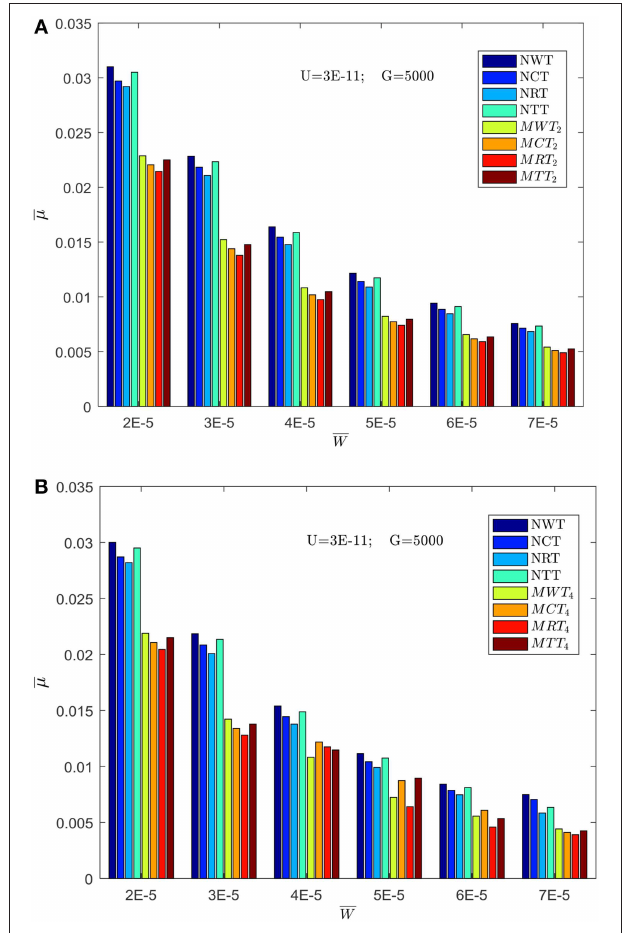
FIGURE 9 | Effect of MHD lubricant parameter [Hm (A) 2, (B) 4] and MTS on coefficient of friction in the inlet zone of EHL line contact at U = 3 × 10 − 11 ; G =